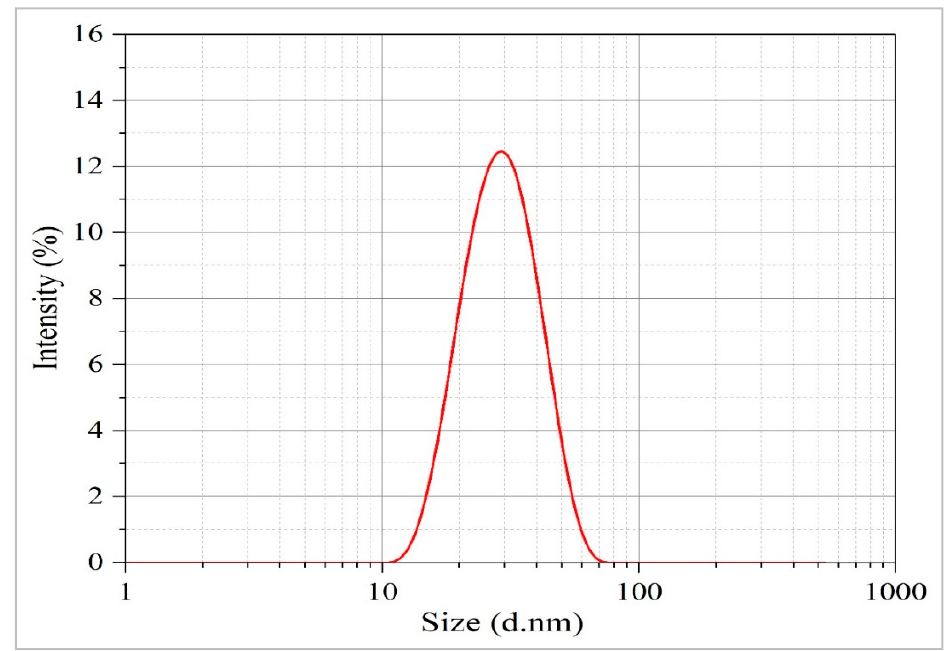
Figure 5. Particle size distribution (PSD) of synthesized nZVI